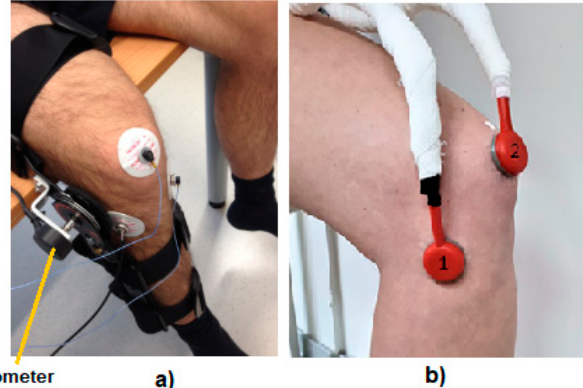
Appl. Sci. 2021 , 11 , x FOR PEER REVIEW Figure 2. Examples of sensors being attached to a knee: ( a ) accelerometers [25], ( b ) microphones [9].